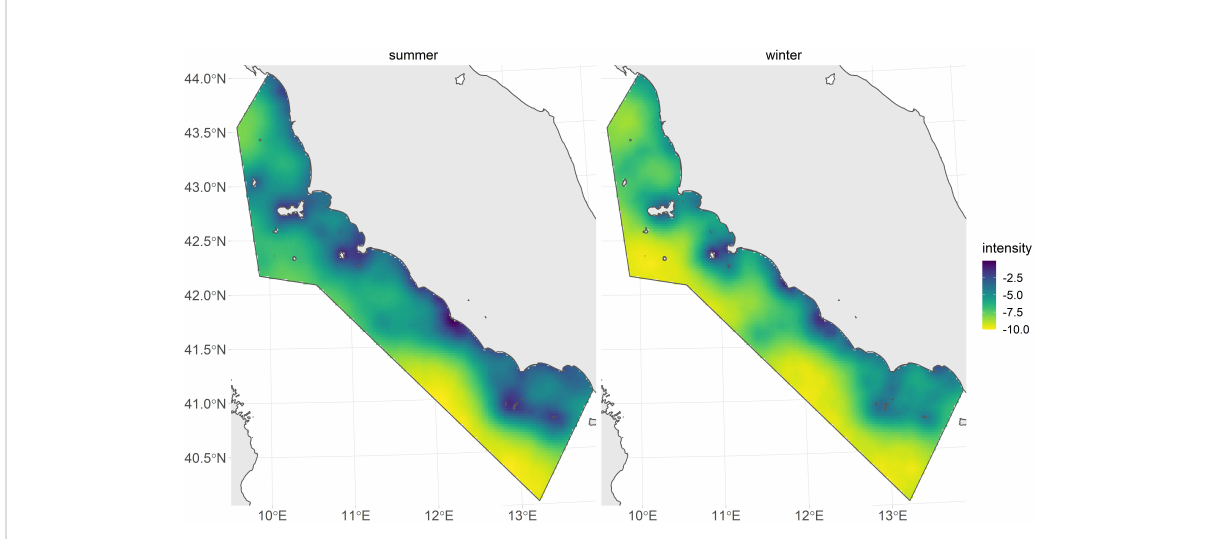
FIGURE 5 Estimated maps of observation process intensity used in the detection functions (summer: left panel; winter: right panel).